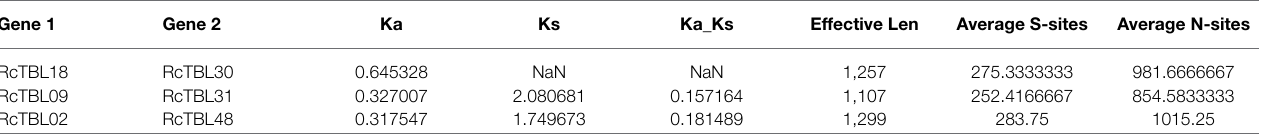
TABLE 2 | Duplication analysis of the RcTBL gene